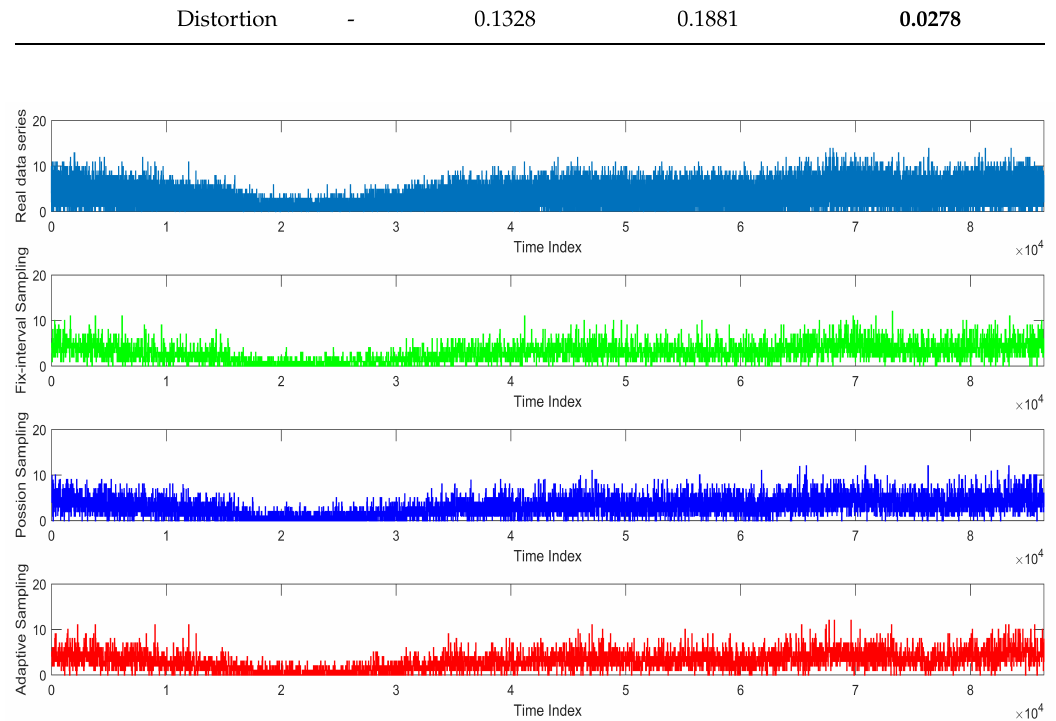
Figure 5. Comparison of different sampling